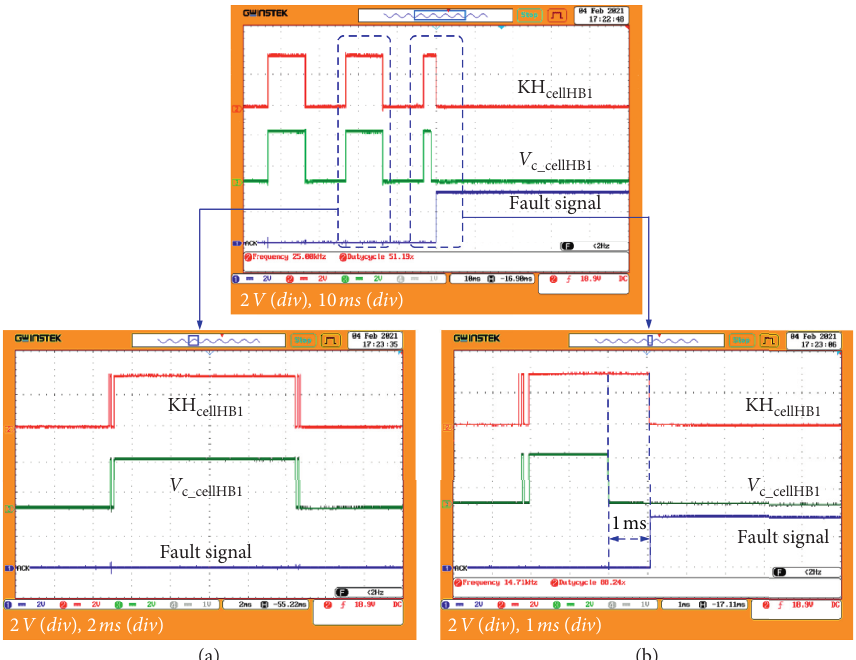
Figure 15: Waveforms of T 1 and T 2, fault signal, and KH condition from experiment.